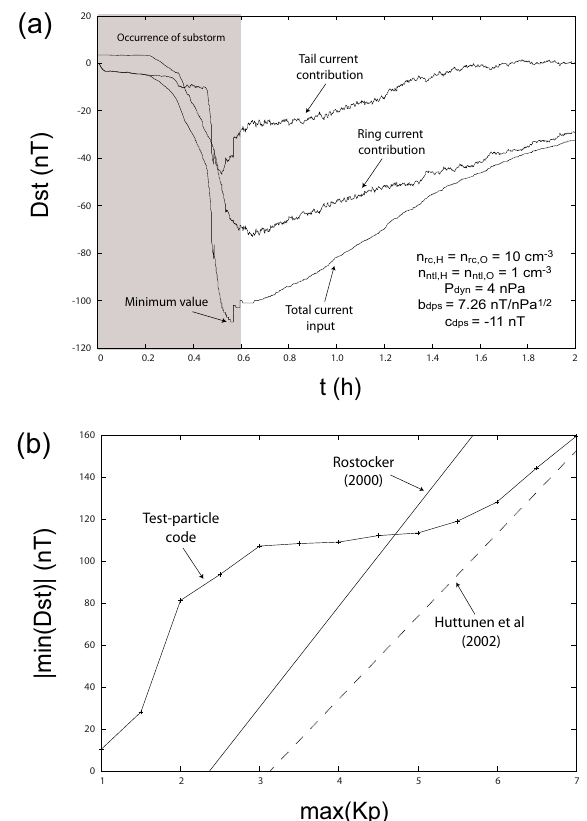
Figure 11. Analysis of Dst based on an ensemble of 2000 test ions, 1000 O + launched from the plasma sheet and 1000 H + in the ring current, during the event introduced in Sect. 2: (a) dynamic evolu- tion of Dst and of its ring/tail current contributions and (b) correla- tion of the maxima of | Dst | and Kp, computed by varying only Kp in (a) , as compared to formerly derived